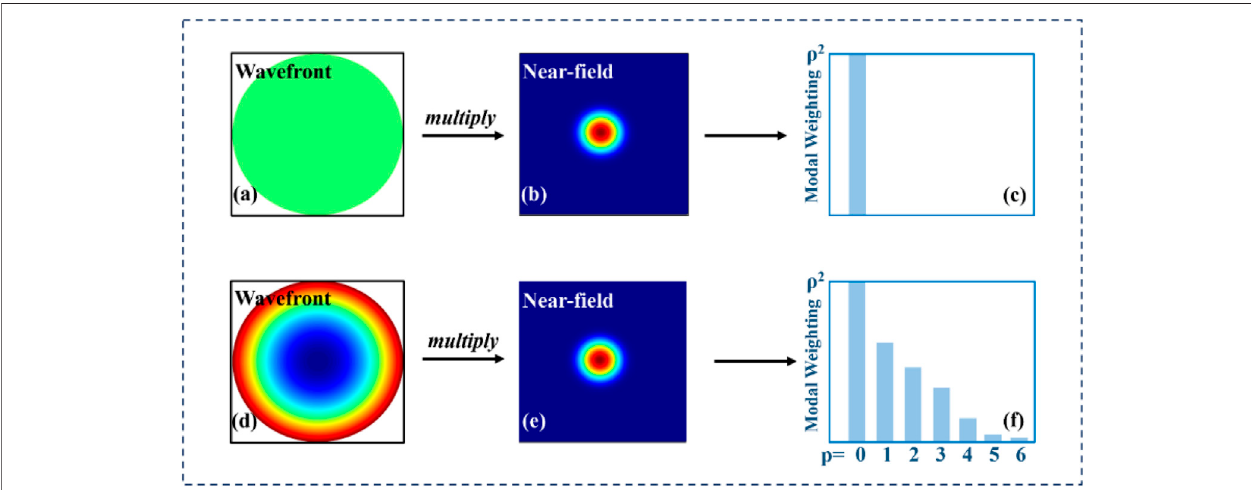
FIGURE2| ModedecompositionresultofanidealfundamentalGuassianbeamwithandwithoutdefocusaberration. (A) Aplanewavefront, (B) near- fi eldintensity of an ideal fundamental Guassian beam, (C) the modal decomposition (MD) result of a pure fundamental Guassian beam without aberration in fl uence, (D) a defocus wavefront, (E) near- fi eldintensity ofan ideal fundamental Guassianbeam, and (F) MD result ofadistortedbeam bythedefocusaberration where theMD result changes into a superposition of several modes. [26].